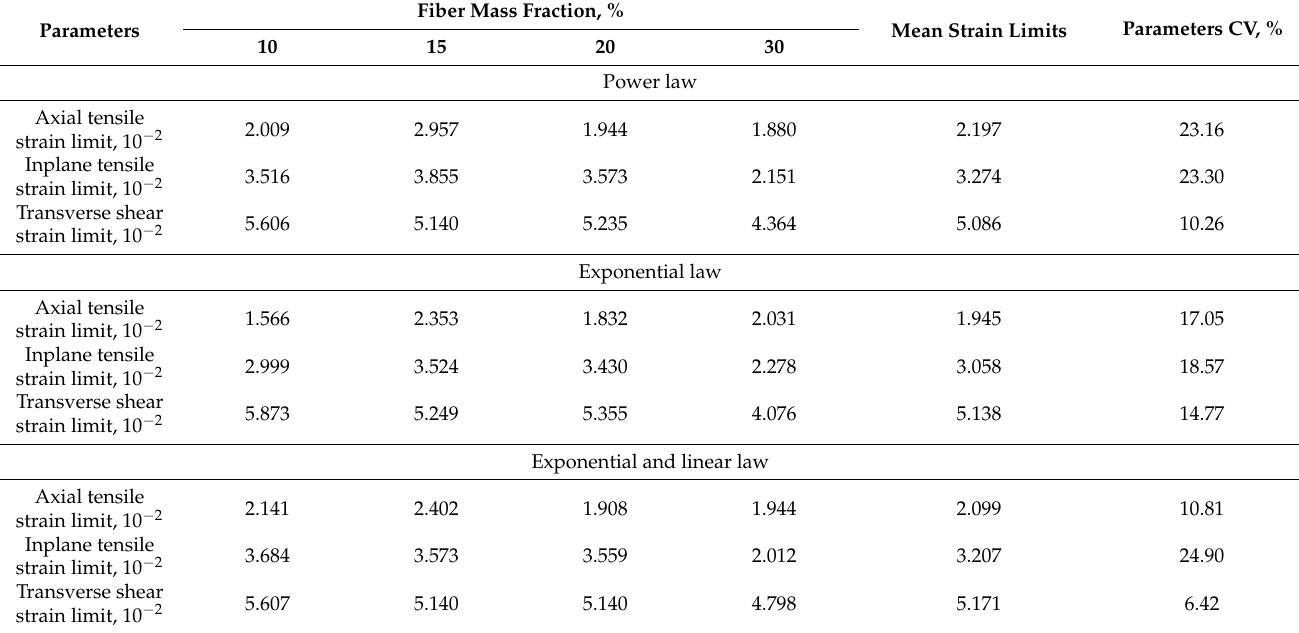
Table 6. Failure criteria strain limits for different fiber mass fraction cases.